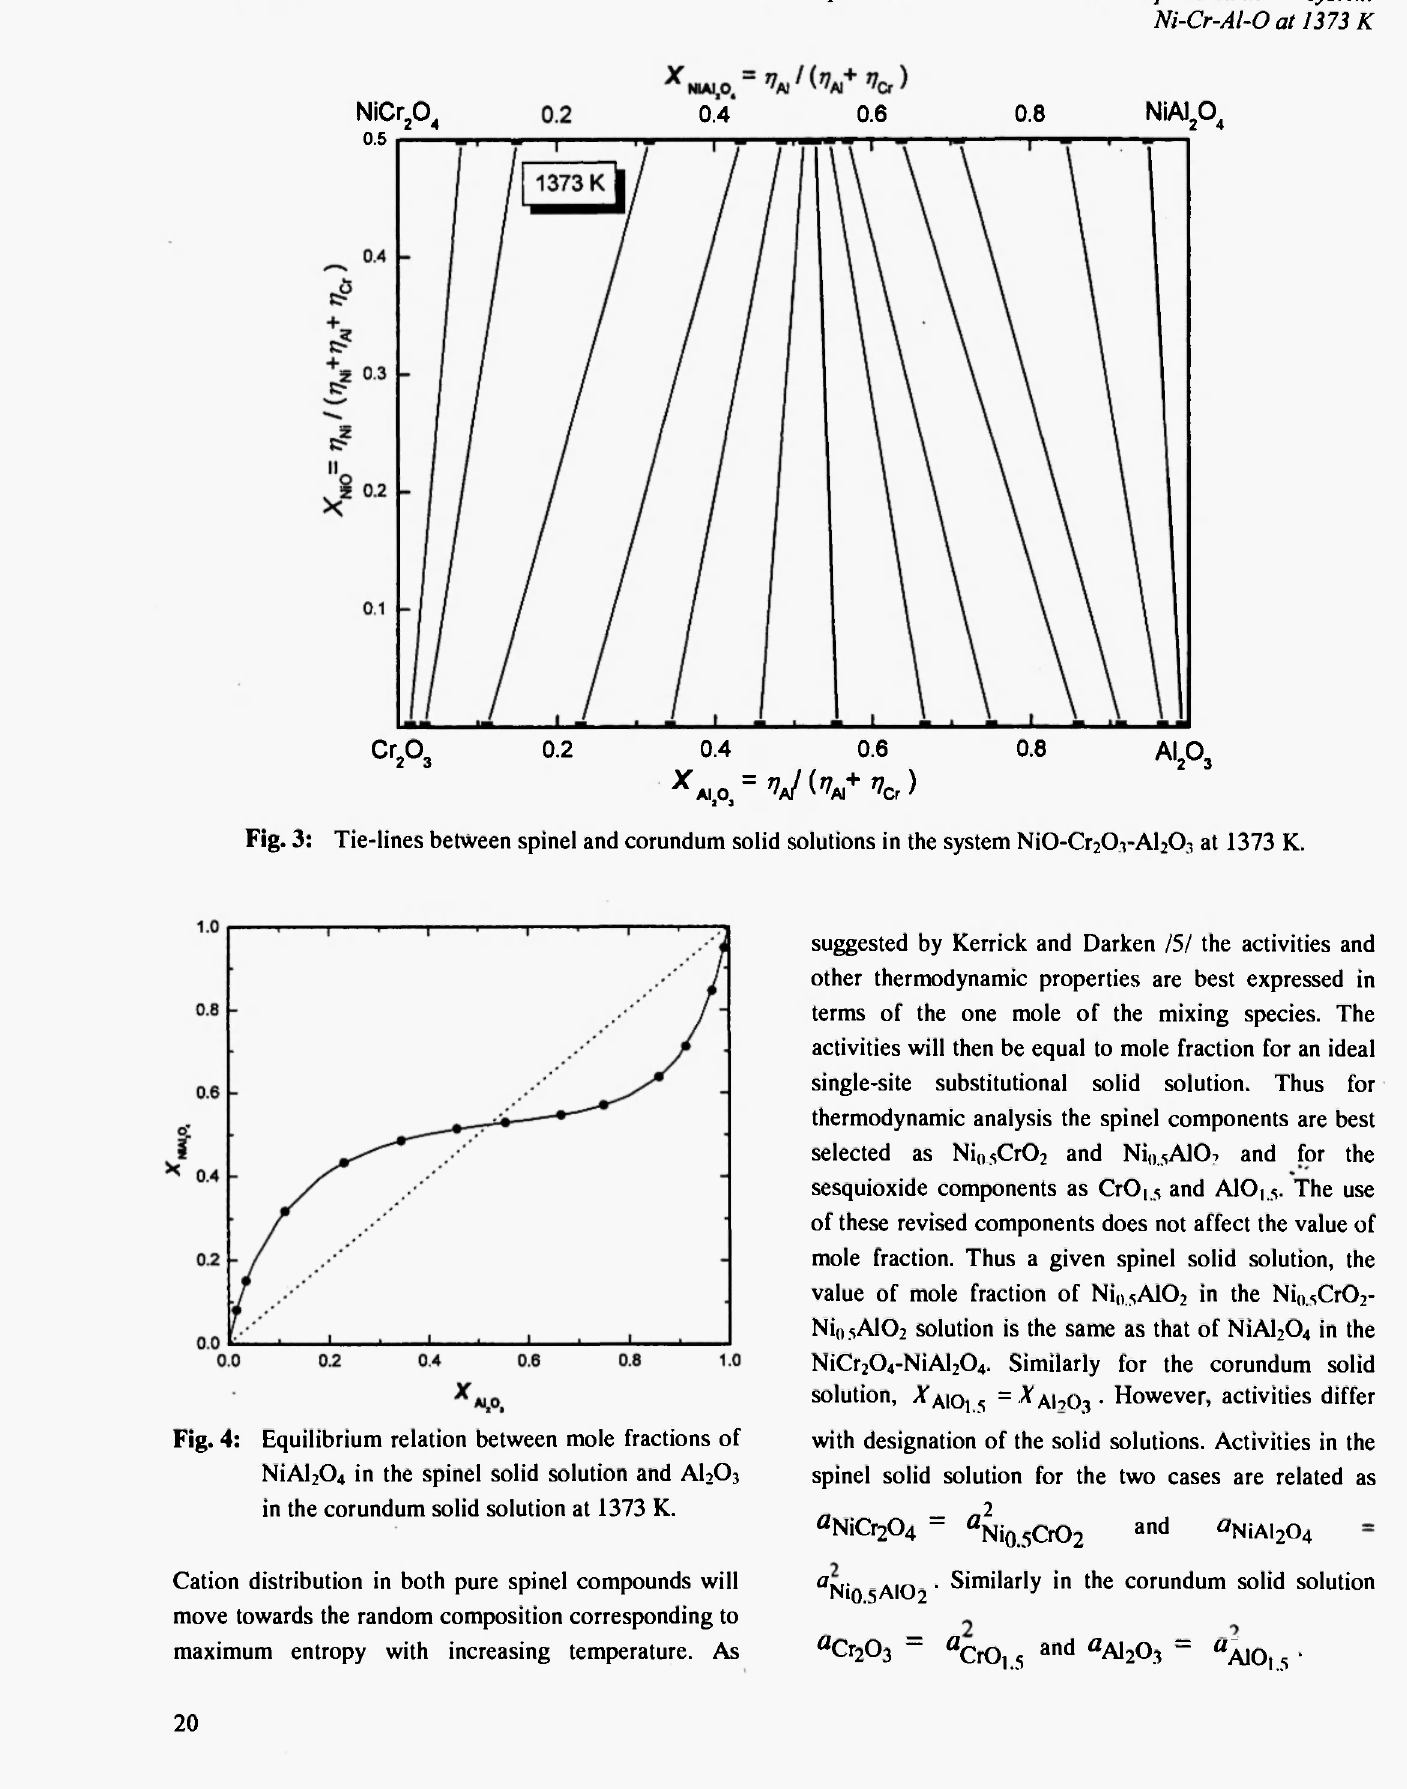
Fig. 4: Equilibrium relation between mole fractions of NiAl 2 0 4 in the spinel solid solution and A1 2 0 3 in the corundum solid solution at 1373